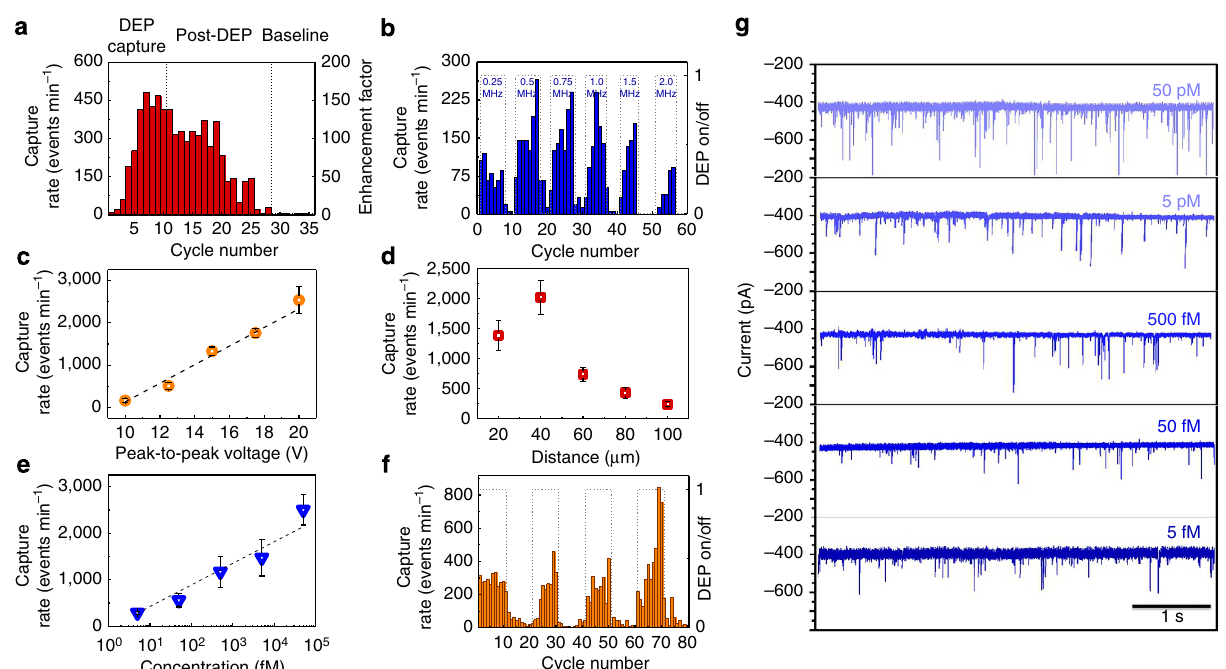
Figure 5 | Analysis of enhanced capture rates. ( a ) Capture rate per recording cycle where each recording cycle was 10s in duration. The first 10 cycles were performed with 10s of DEP pre-concentration, whereas the last 25 cycles were proceeded by 10s of no trapping forces. ( b ) Capture rate per recording cycle where DEP pre-concentration was turned on/off. The DEP trapping frequency was also increased with each subsequent DEP pre-concentration phase ( V pp ¼ 12V). ( c ) Capture rate as a function of the peak-to-peak voltage used for the DEP trapping ( f AC ¼ 1MHz). ( d ) Capture rate as a function of the nanopipette tip-counter electrode gap distance ( V pp ¼ 12V, f AC ¼ 1MHz). ( e ) Capture rate as a function of the 10kbp DNA concentration. ( f ) Capture rate per recording cycle for a 5fM DNA sample where DEP pre-concentration was turned on and off for four consecutive cycles ( V pp ¼ 20V, f AC ¼ 1MHz and d gap ¼ 20 m m). ( g ) Current traces obtained using DEP as a pre-concentration step for five different concentrations (50pM, 5pM, 500fM, 50fM and 5fM). A bias of | D V | ¼ 500mV was applied across the nanopore for all the experiments.